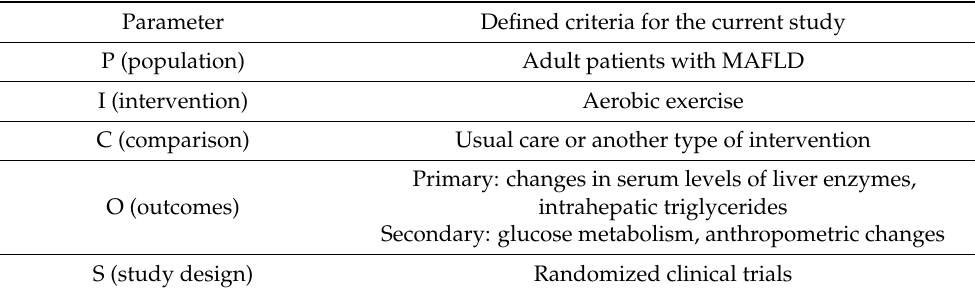
Table 1. PICOS criteria for inclusion and exclusion of